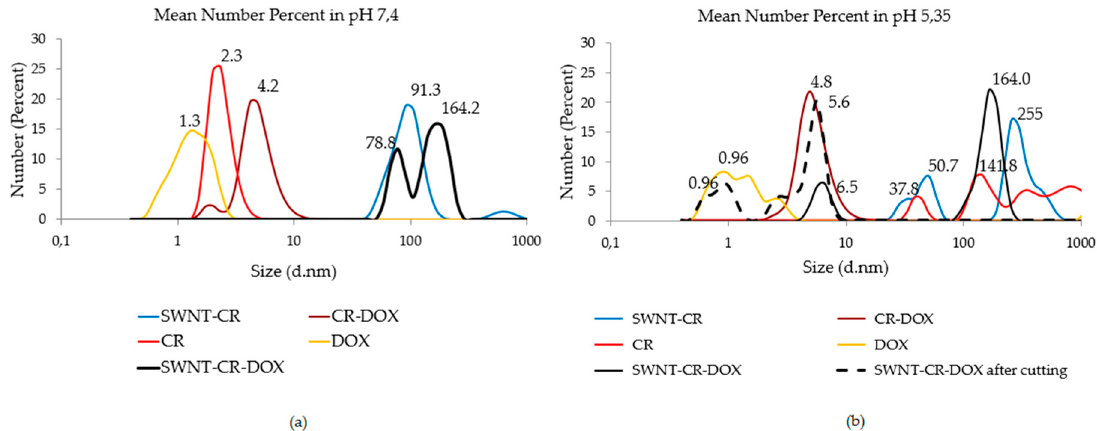
Figure 2. Hydrodynamic diameter distribution measurements (CR, DOX, CR-DOX, SWNT-CR, SWNT-CR-DOX and SWNT-CR-DOX after rejection of aggregates larger than 40 nm—dashed black line). Mean number percent at: ( a ) pH 7.4 ( b ) pH 5.35.